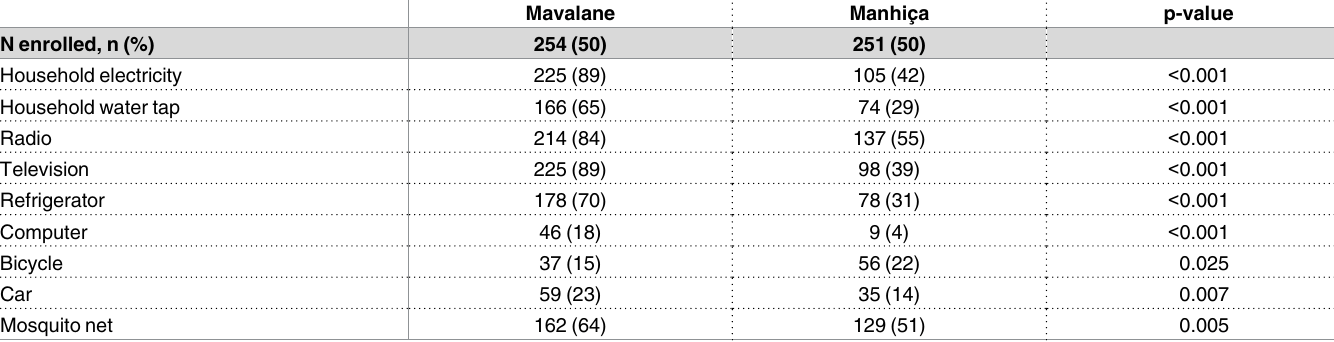
Table 5. Socio-economic characteristics at enrolment: Proportion of women who reported household ownership of